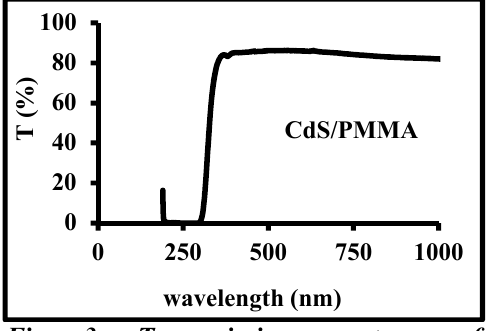
Fig. 3: Transmission spectrum of CdS/PMMA thin film.